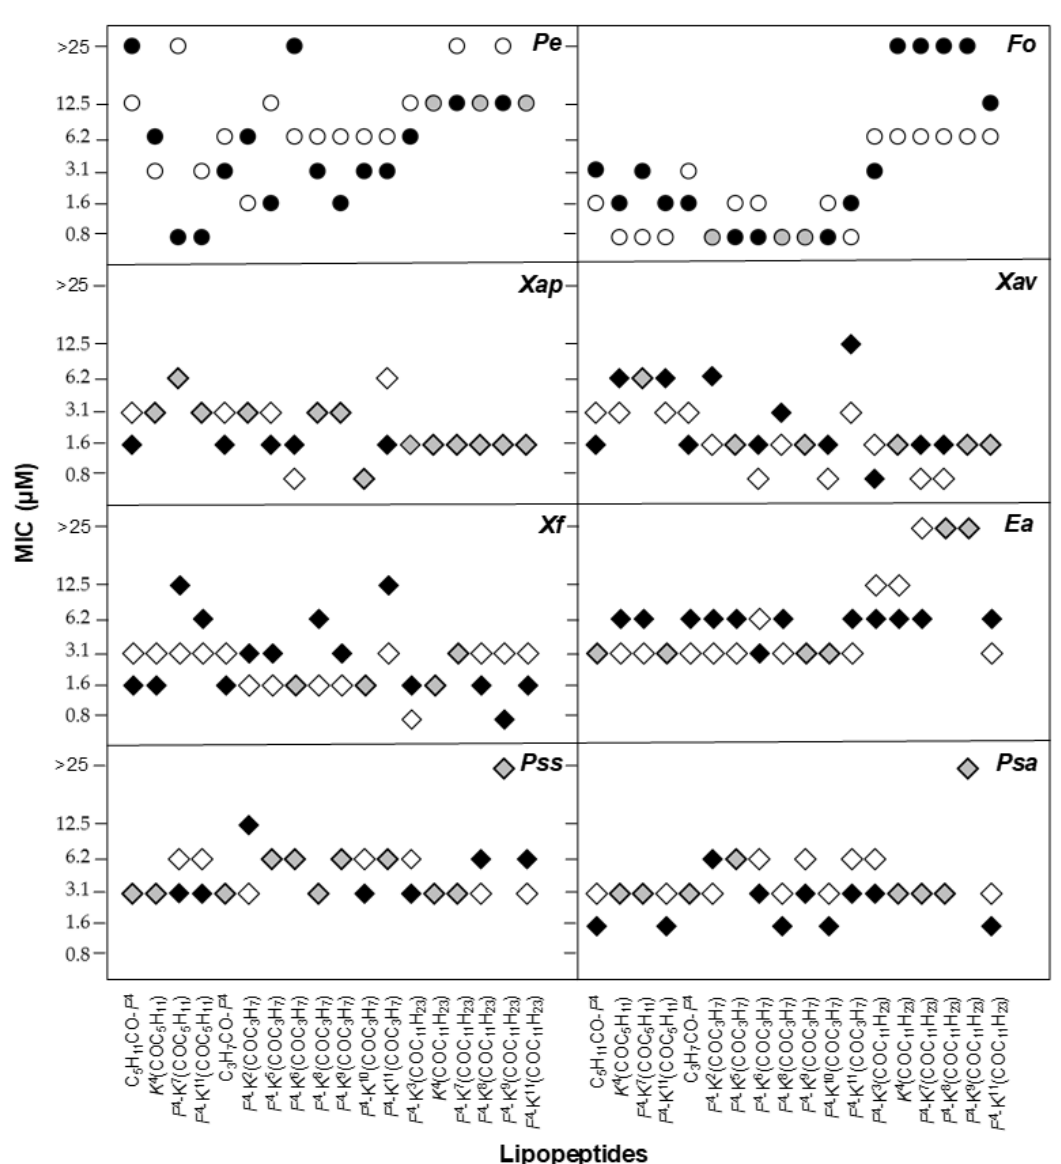
Figure 4. Antimicrobial activity of lipopeptides incorporating all L -amino acids or a D -amino acid against E. amylovora ( Ea ), P. syringae pv. syringae ( Pss ), P. syringae pv. actinidiae ( Psa ), X. fragariae ( Xf ), X. arboricola pv. pruni ( Xap ) and X. axonopodis pv. vesicatoria ( Xav ), and the fungi P. expansum ( Pe ) and F. oxysporum ( Fo ). The x axis includes the code for each lipopeptide. The residue that can be a L - or a D -amino acid is indicated in italics. Antimicrobial activity is given as the minimal concentration that inhibits growth (MIC). The MIC axis is in logarithmic scale and for each sequence the lowest values of the MIC range is represented. Black symbols correspond to the activity of lipopeptides with a D -amino acid, white symbols to the activity of lipopeptides with all L -amino acids, and grey symbols indicate that both lipopeptides display the same activity. Data can be found in Table S1 (Supplementary Materials).